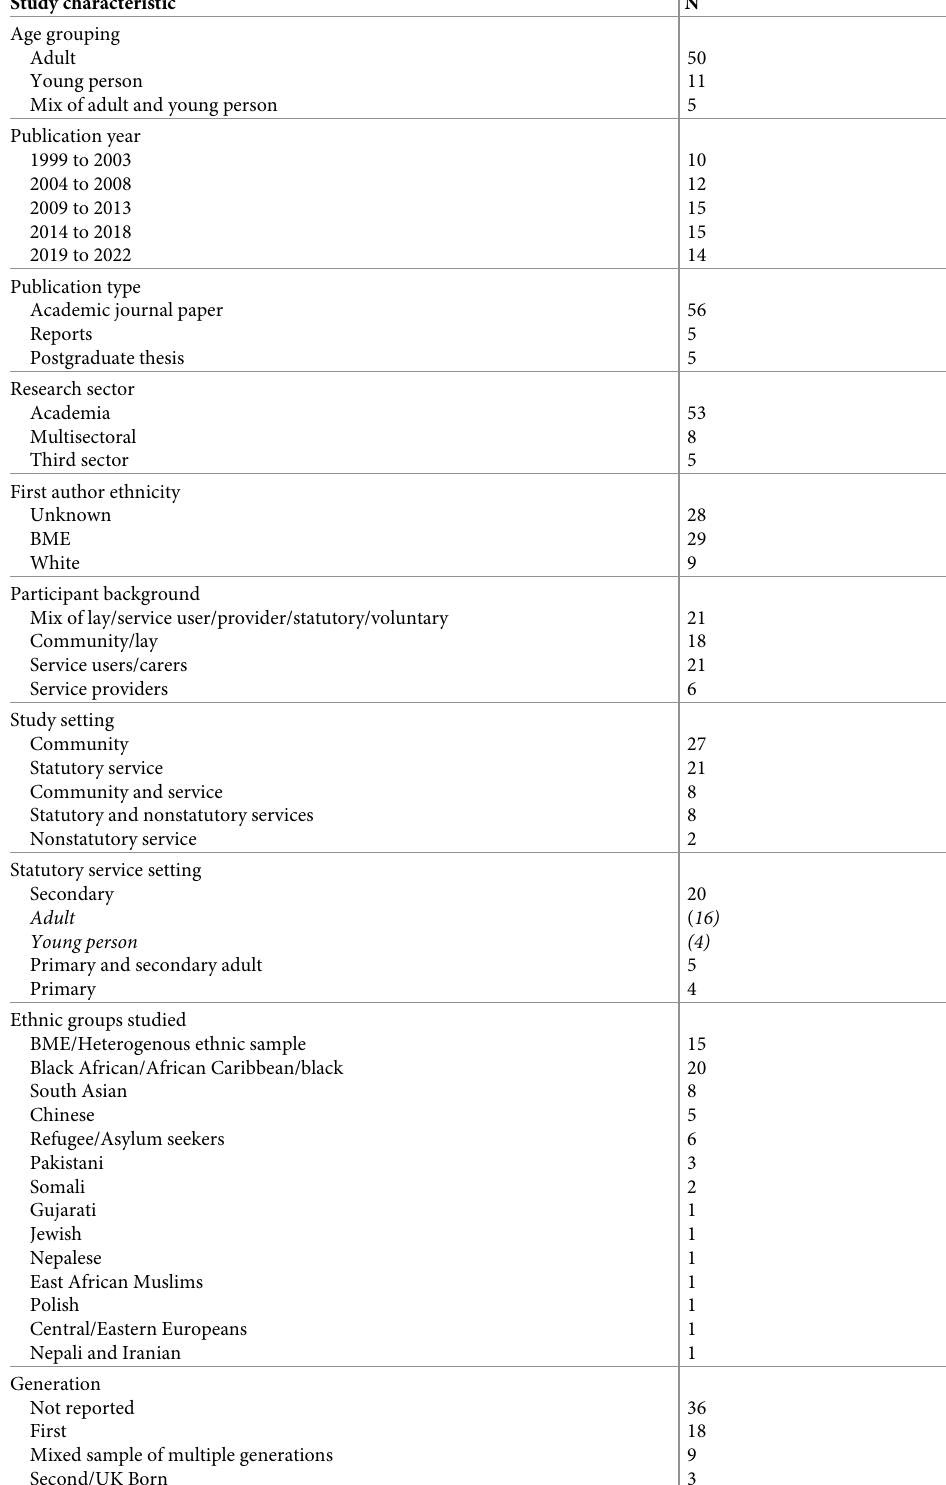
Table 2. Summary study characteristics of included